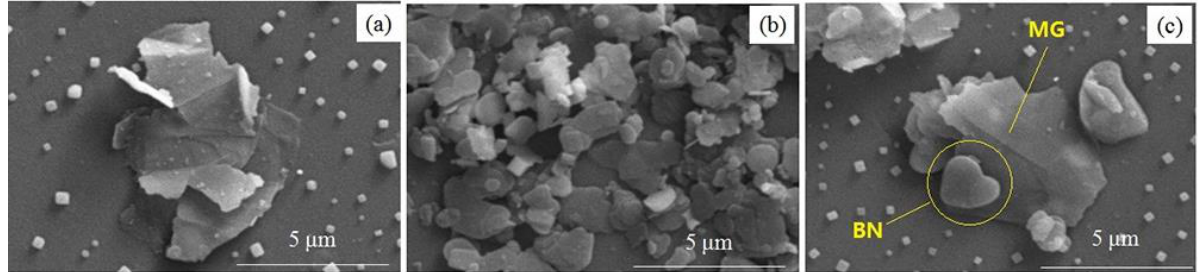
Figure 6. SEM images of MG ( a ), BN ( b ), and BN − MG ( c ). TGA tests were carried out under a nitrogen atmosphere to evaluate the thermal stabilities of BN, PDDA@BN, MG, and BN − MG. The obtained curves are shown in Figure 7. BN shows negligible weight loss (less than 1% at 750 °C), demonstrating its high thermal stability. As for PDDA@BN, two degradation stages before 450 °C can be found in its TGA curve. The first stage in the range of 100~200 °C is the volatilization of small molecular impurities such as trace moisture remaining in the sample. The second stage, between 300 °C and 400 °C, is mainly due to the decomposition of PDDA. Because of the small wrap- ping amount of PDDA in PDDA@BN, no further weight loss above 450 °C can be found after the decomposition of PDDA and thus maintains good thermal stability. By compar- ison, the thermal stability of MG sheets prepared by the wet ball milling method is not as good as that of BN due to the presence of hydroxyl groups on the MG surface; however, the weight loss value of MG and BN − MG at 750 °C is only 1.7 wt.% and 1.8 wt.%, respec- tively, proving the good thermal stability of both MG − based nanofillers. Figure 7. TGA curves for BN, PDDA@BN, MG, and BN − MG.